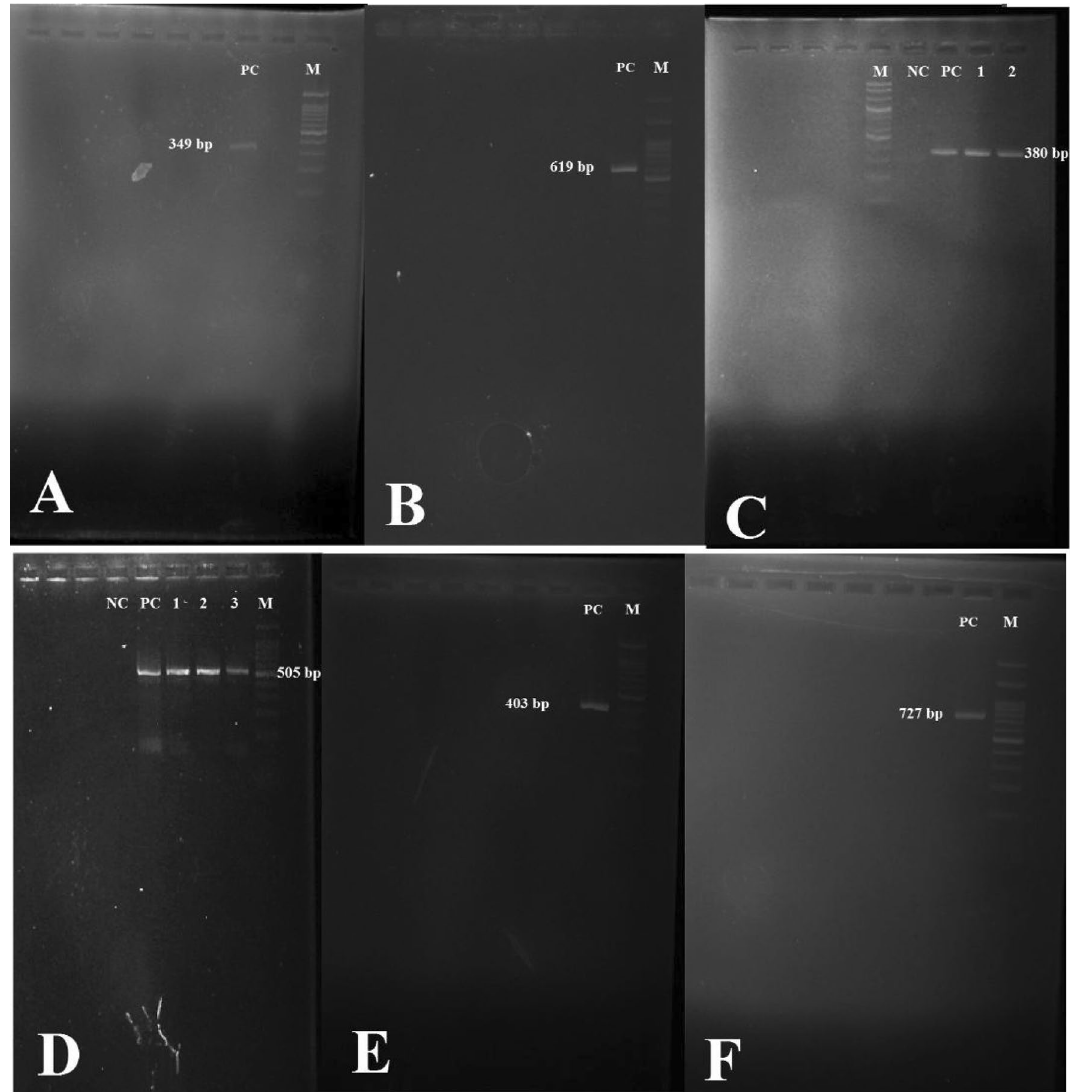
Figure 1. Gel electrophoresis of dfrA gene (panel A , PC: Staphylococcus epidermidis ATCC 12228), sulf2 gene (panel B , PC: Escherichia coli strain AMR 130), sulf1 gene (panel C , PC: Escherichia coli strain AMR 130, 1: Nocardia otitidiscaviarum , 2: Nocardia flavorosea ), int1 gene (panel D , PC: Vibrio cholerae O1 strain SK-10, 1: Nocardia otitidiscaviarum , 2: Nocardia flavorosea , 3: Nocardia otitidiscaviarum ), int2 gene (panel E , PC: E. coli strain having a R483), and i nt3 gene (panel F , PC: E. coli strain having a pSMB731) PCR products. M Marker, PC positive control, NC negative